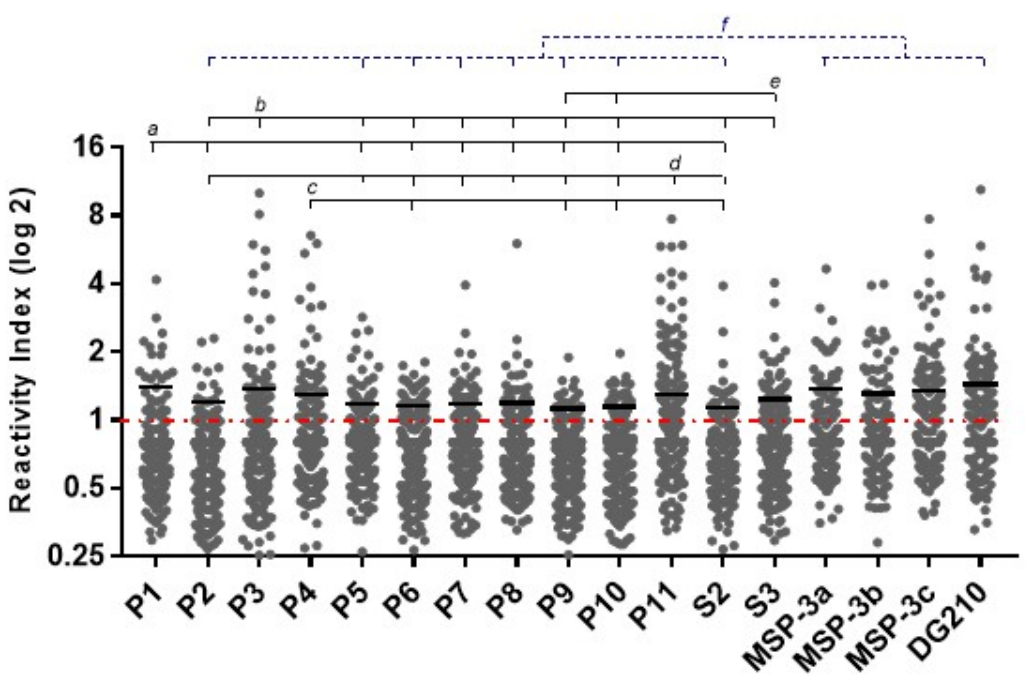
Figure 3. Levels of IgG antibodies (reactivity index) against GLURP 27–500 and MSP-3 155–249 epitopes. Reactivity indices are individual values. The dashed red line represents the positivity limit. Lines represent the median. a : p < 0.05 P1 versus P2, P5, P7, and P8; p < 0.005 P1 versus P6, P9, P10, and